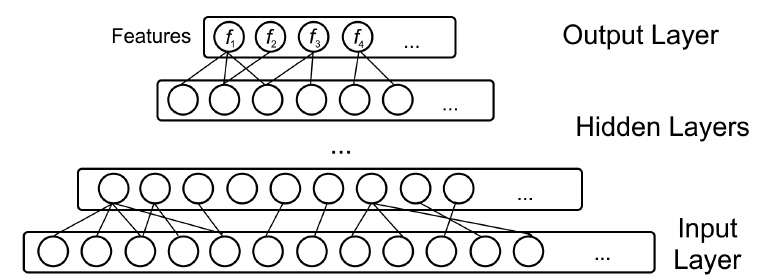
Figure 2. Architecture of the Deep Belief